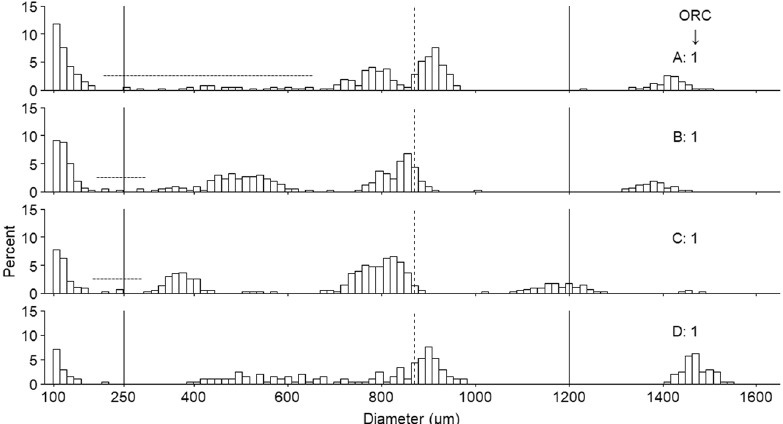
Figure 1. Examples of assumingly atypical oocyte frequency distribution (OSFD) of spawning individuals. ( A–C ) OSFDs demonstrating the subjective nature of hiatus placement. Placement of the gap limits should theoretically be placed at the upper and lower edge of the PVO and VO cohort, respectively. However, the limits could subjectively be placed at multiple positions within the region indicated by the horizontal dashed line. Furthermore, panel D exemplifies an OSFD where the VO cohort has an unusually long ‘tail’. The upper and lower thresholds used for calculation of oocyte ratio (OR) are shown by the solid vertical lines, the vertical dashed line is the approximate point at which oocytes enter final oocyte maturation (FOM) 20 . All fish in this figure have an oocyte ratio category (ORC) of 1 for standardisation purposes. Oocytes < 250 µ m are PVOs, 250 to 1200 µ m are developing oocytes (VO and FOM), and > 1200 µ m hydrated or ovulated oocytes. Panel C exemplifies an individual with ‘swelling’ oocytes which are at the end of FOM (see mode at ≈ 1200 µ